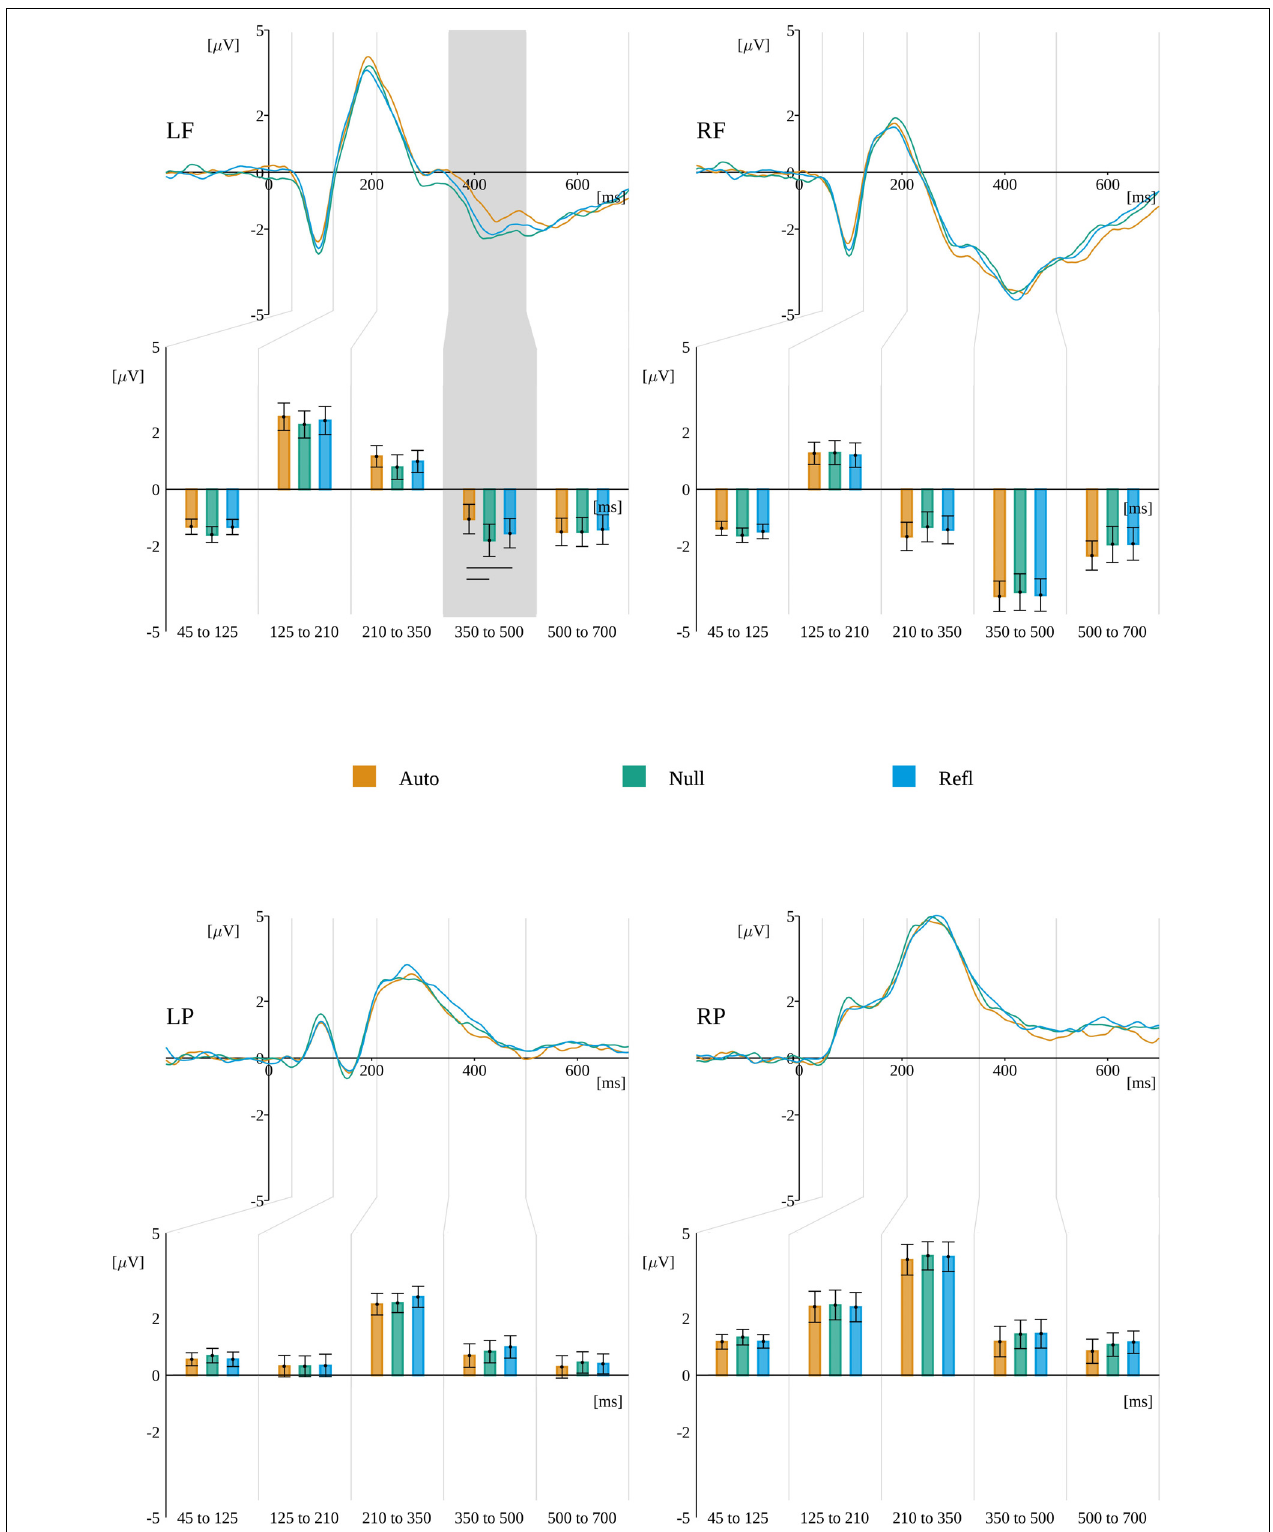
FIGURE 8 | Effects of origin in subsequent time windows during the word reading. For each ROI the time course of ERP for each level of origin is plotted. Gray backgrounds mark time windows with statistically significant origin ∗ ROI interaction. Beneath, the bars present the amplitude averaged within each time window. Horizontal lines indicate levels of origin that differ significantly from each